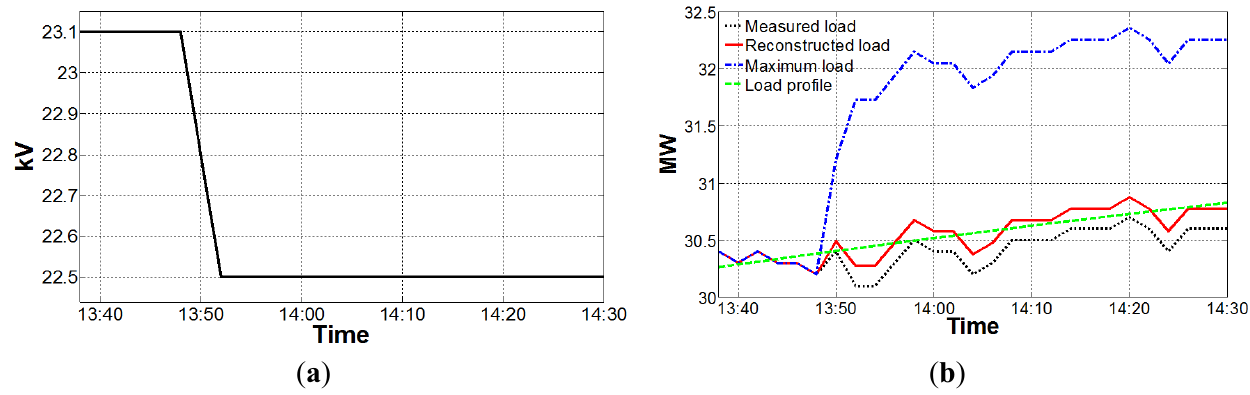
Figure 3. Results of the nationwide CVR implemented at the 480th transformer bank on 9 August 2012: ( a ) measured bank voltage; and ( b ) transformer-bank load.